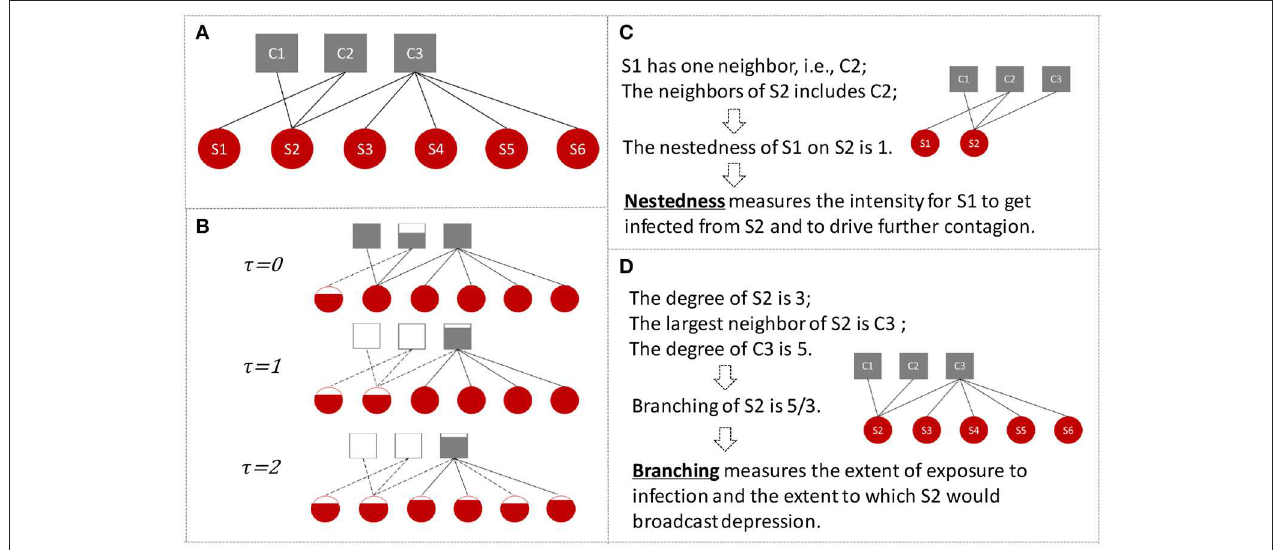
FIGURE 1 | The stock-investor network illustration. (A) Shows the network compositions, where the gray squares are investors and the red circles are stocks. Edges exist only from one kind of nodes to the other and edge weights represent how much the investors invest on the corresponding stocks with respect to market values. It is an undirected weighted network. (B) Shows the contagion procedure. The initial shock is stock S1 reaching its price limit and losing c proportions of its market value. The lack of liquidity results from this leads to investor C2 faces a proportion of share holdings being locked. This further makes C2 sell other stocks in hand at τ = 1, i.e., S2, which then conveys the depression to C1, and so on and forth. (C,D) Shows the examples of “nestedness” and “branching” that defined in section